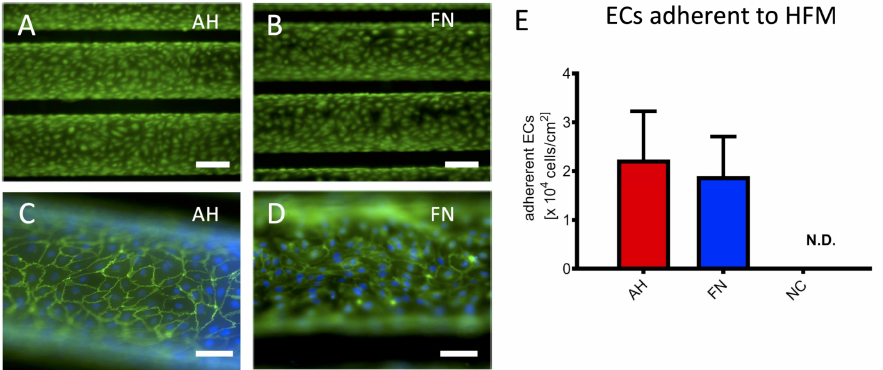
Figure 2. Viability, confluence and quantification of ECs adherent to HFM. Viable ECs on AH ( A ) and FN ( B ) coated HFM were visualized using calcein staining ( green ); Scale: 200 µ m, VE-cadherin ( green ) and Hoechst ( blue ) indicated intercellular connection between ECs on AH ( C ) and FN ( D ) coated HFM; Scale: 100 µ m. ( E ) Quantification of adherent ECs on AH and FN coated HFM, ECs on non-coated (NC) HFM were not detectable